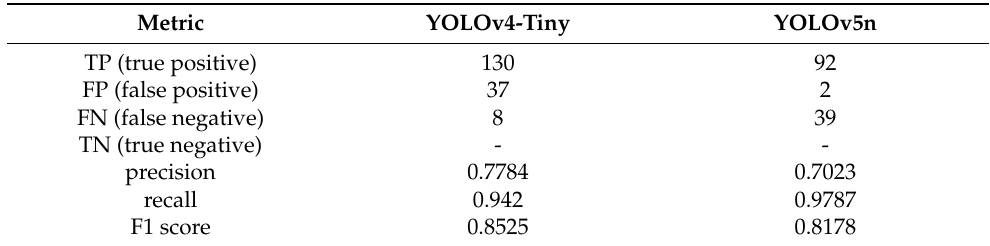
Table 4. Summary of RCW cavity detection performance by YOLOv4-tiny and YOLOv5n.